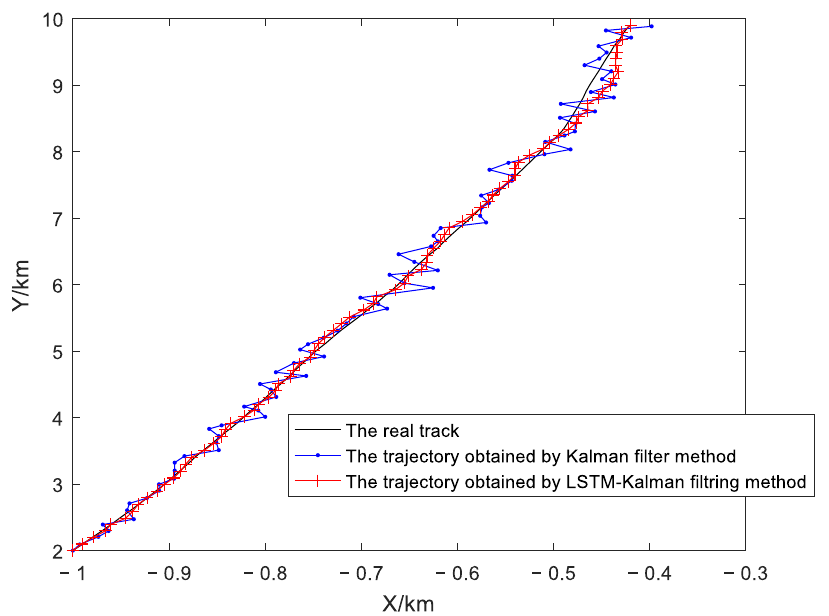
Figure 10. Comparison of the real path, the tracking trajectory that was obtained using the Kalman filtering method, and the tracking trajectory that was obtained using the LSTM–Kalman filtering method.